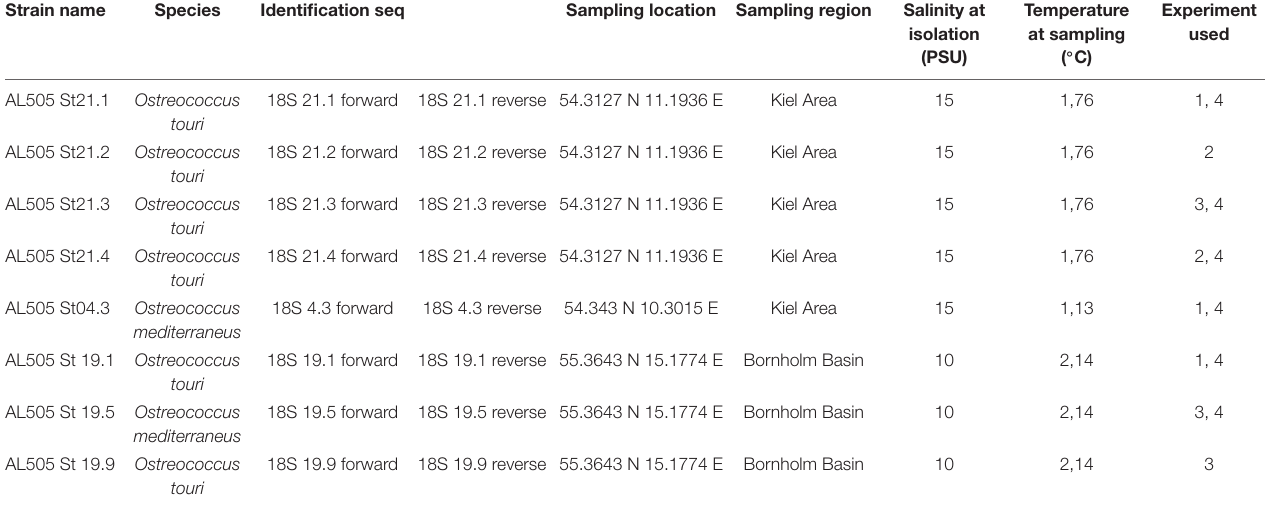
TABLE 1 | This table summarizes the different origins of the strains that were used in the experiments.